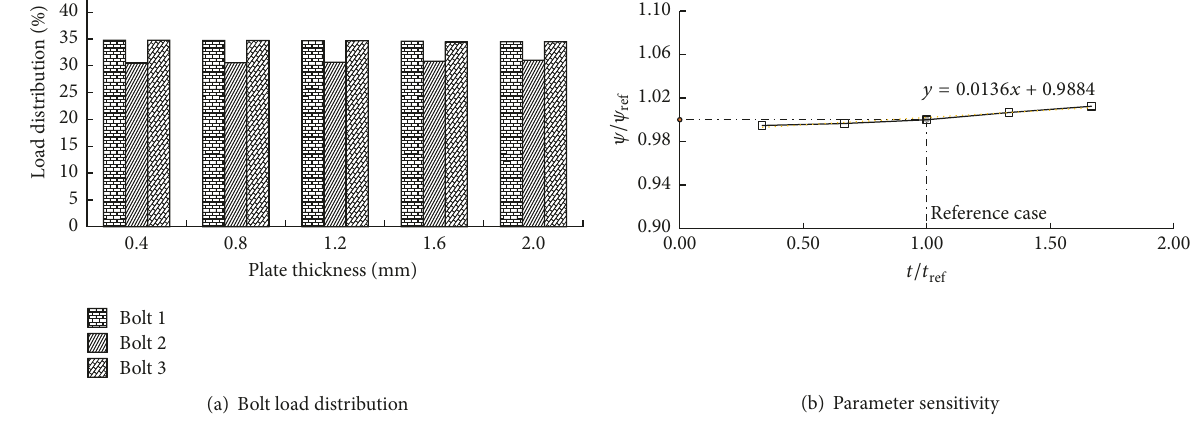
Figure 23: Bolt load distribution and sensitivity analysis results of varying bolt diameters.